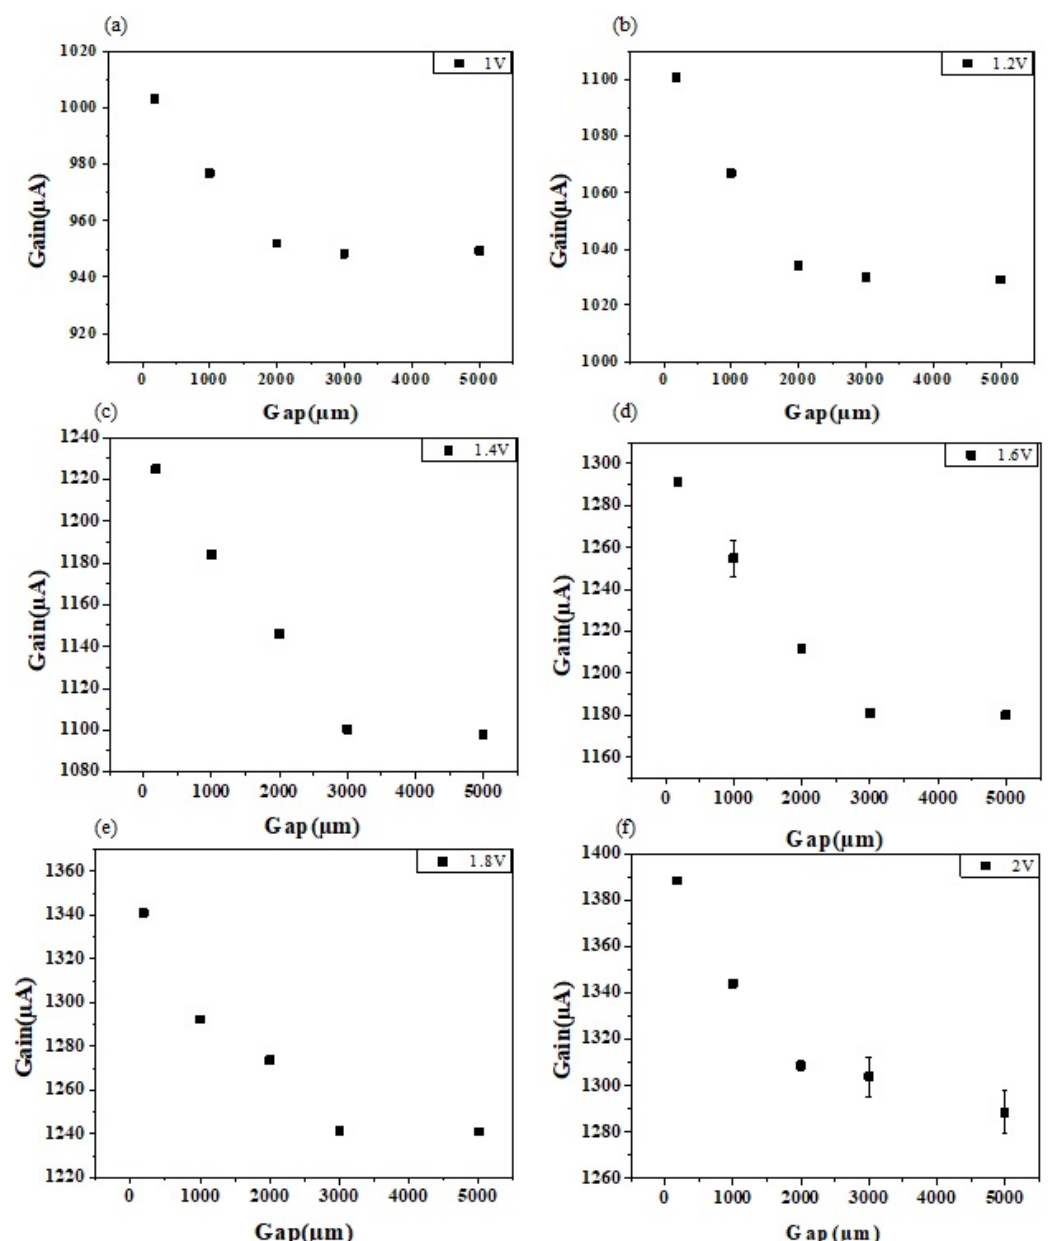
Figure 4. E ff ect of gap distance between sensing and reference electrodes and applied Vg on current gain. ( a )–( f ) Current gain versus di ff erent gap distance for fixed